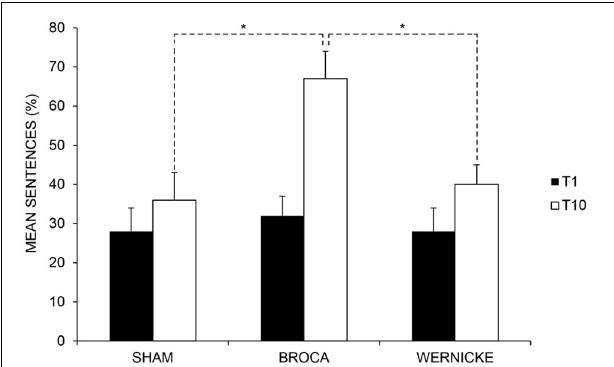
FIGURE 5 | Mean percentage of correct sentences at baseline (T1) and at the end of treatment (T10) for the left anodic Wernicke’s, Broca’s and sham conditions ( ∗ < 0.01), respectively. Error bars represent standard error of the mean.